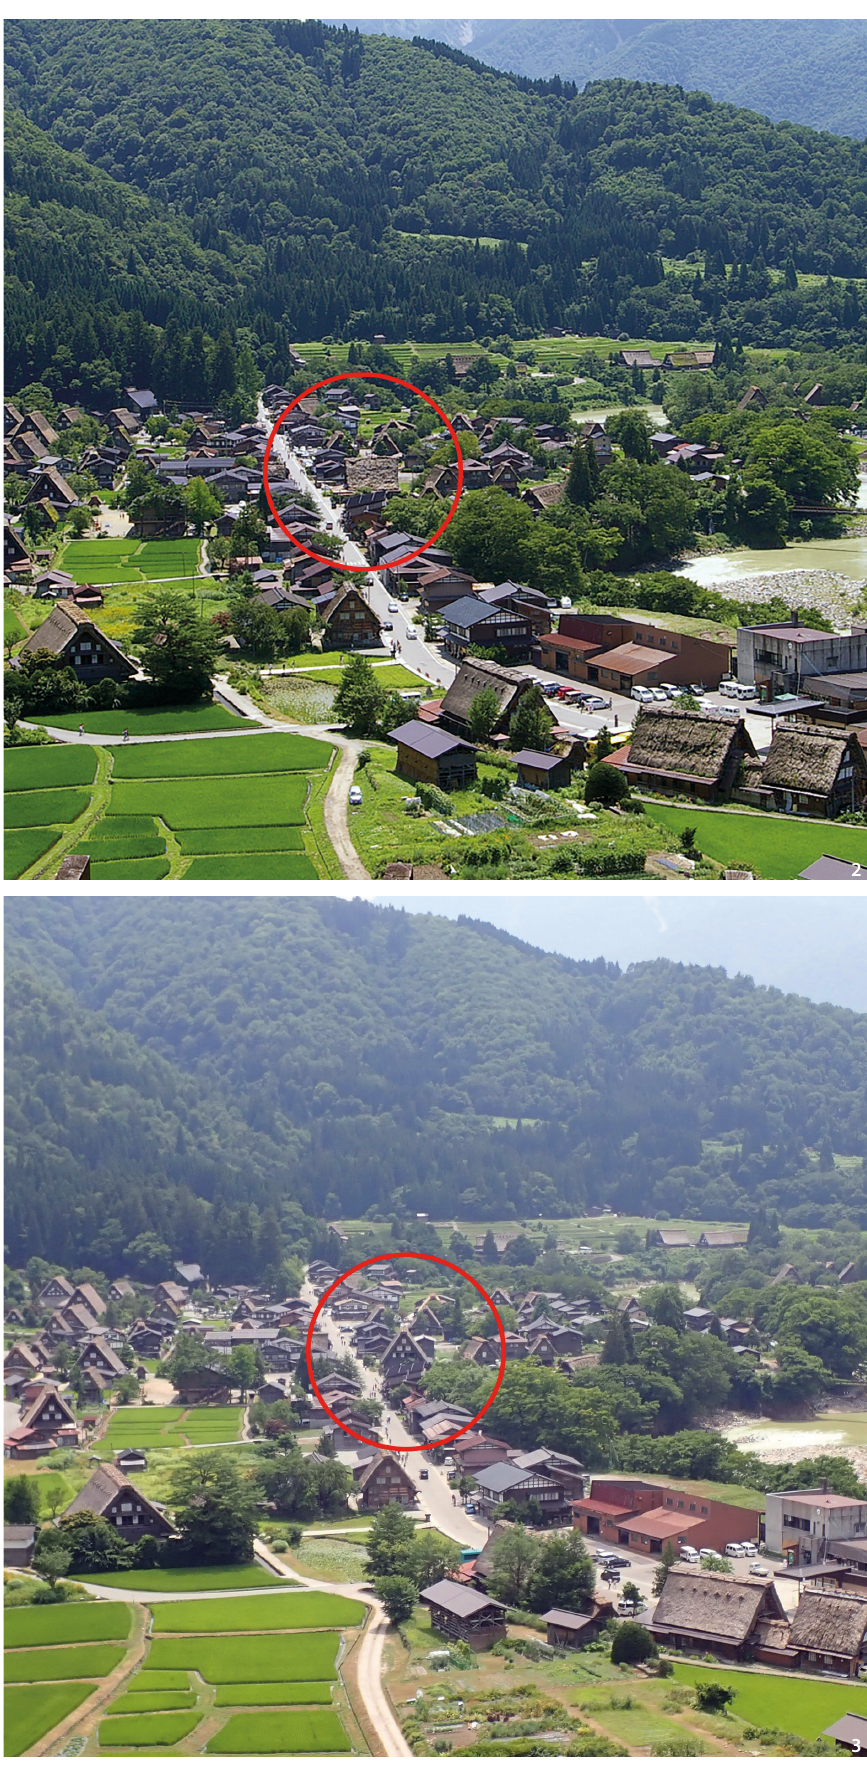
Figure 2 Gassho-style house in 2009: Before restoration (Source: the author). Figure 3 Gassho-style house in 2018: After restoration (Source: the